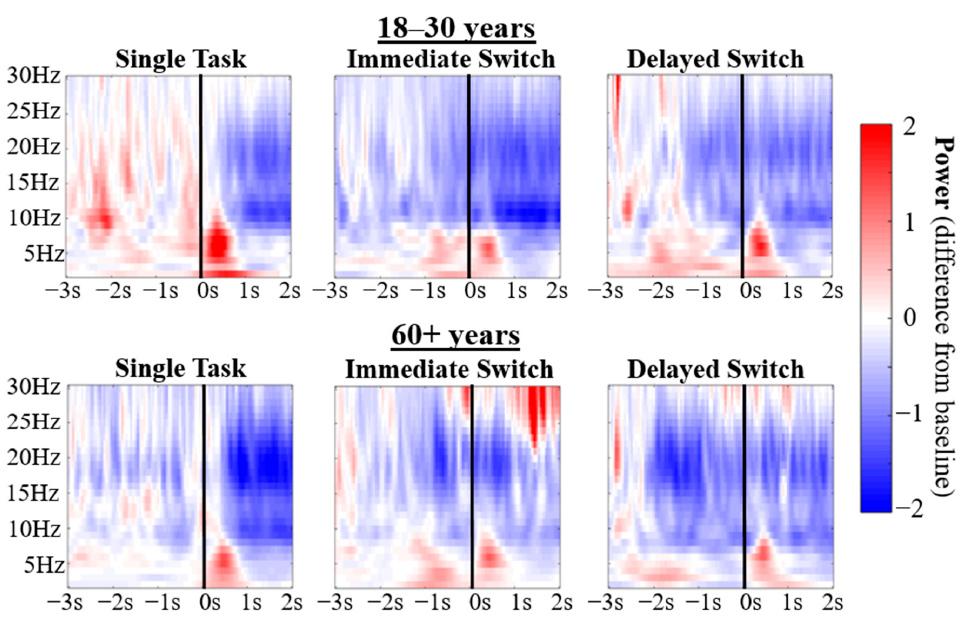
Figure 3. TFRs present power difference from a baseline period of − 5.50 s – − 3.50 s averaged across a group of 12 anterior electrodes (AF3, AF4, F1, F2, F3, F4, FC1, FC2, FC3, FC4, FC5, FC6). For an average across posterior electrodes see Figure S4 and across all electrodes see Figure S5. Black lines placed over TFRs signify the onset of the road sign at 0.00 s. In the Sequential-Task conditions the car pulled in front of the participant at either 3.04 m (~0.14 s; Immediate Switch) or 30.48 m (~1.42 s; Delayed Switch) prior to the onset of the road